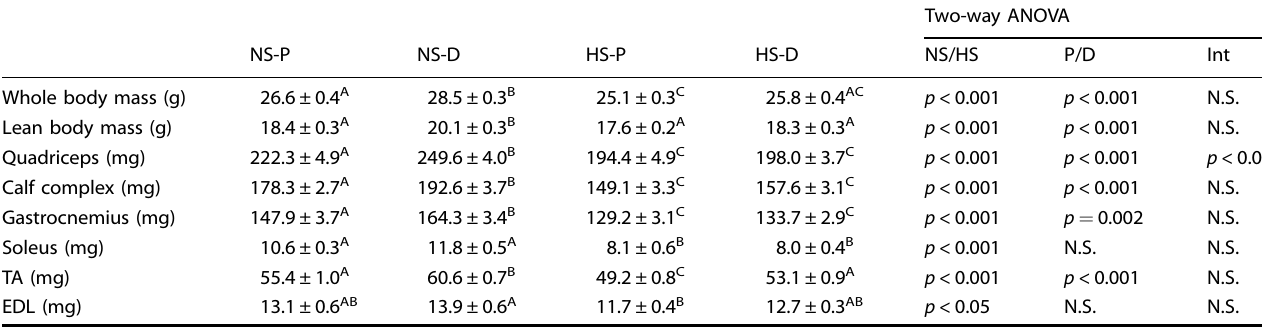
Table 1. Whole body, lean body, and wet muscle